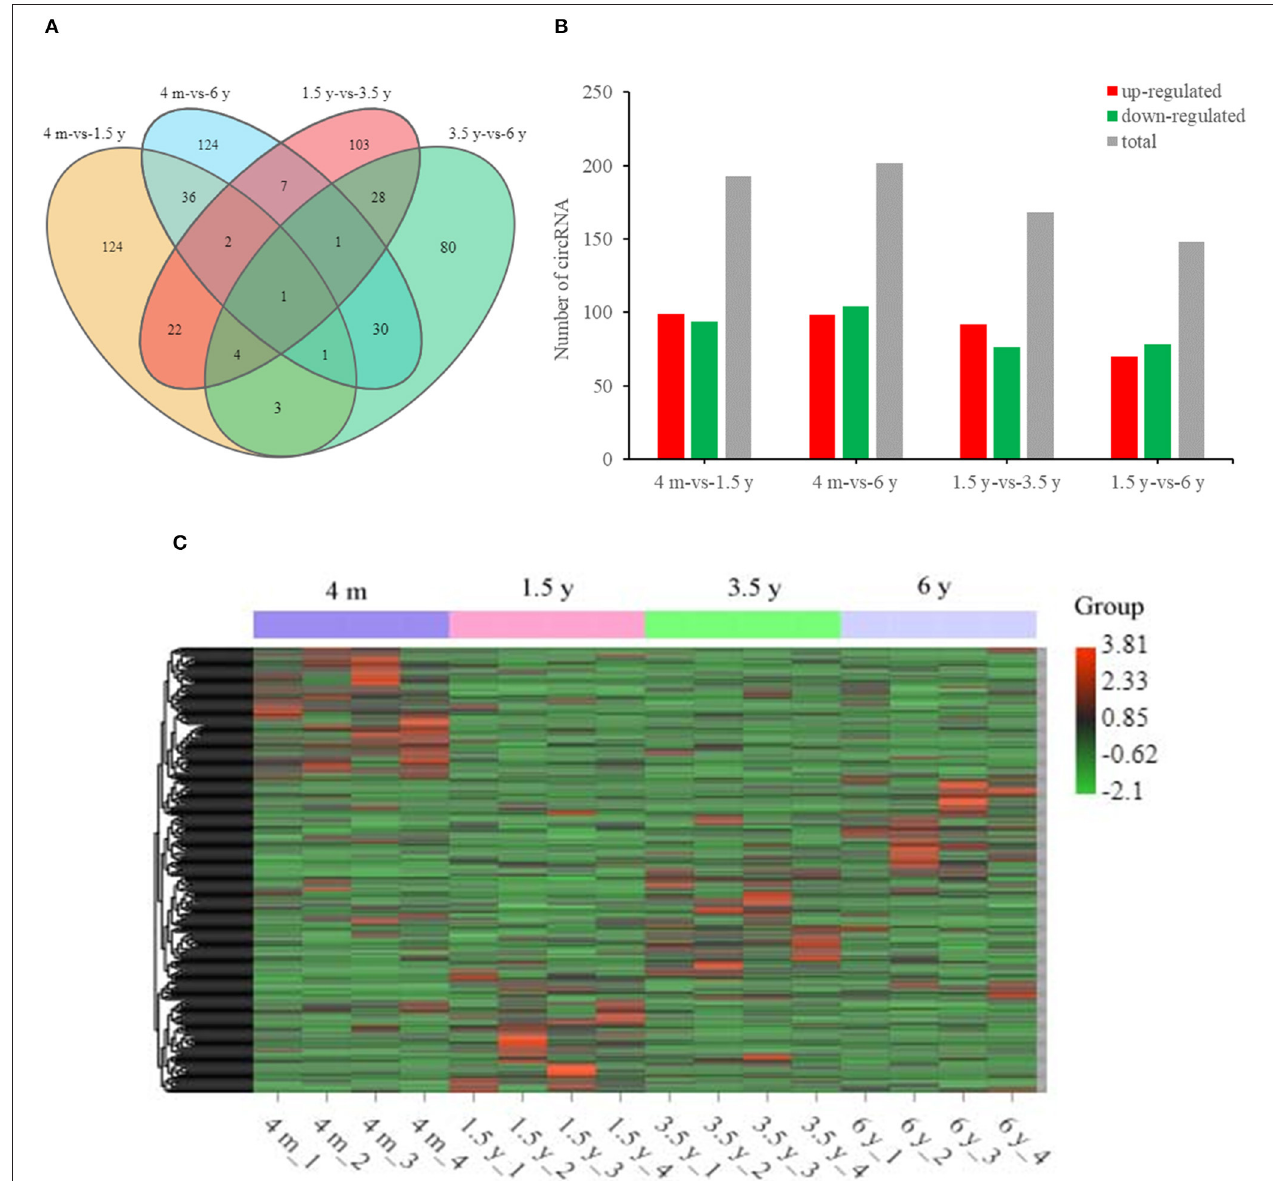
FIGURE 3 | Summary of circRNA differential expression analysis. (A) The Venn diagrams of the shared and unique differential circRNAs in the four comparative groups. (B) Statistics of DE circRNA in the four comparative groups. (C) Cluster heat map of DE circRNA expression. Red means upregulation, green means